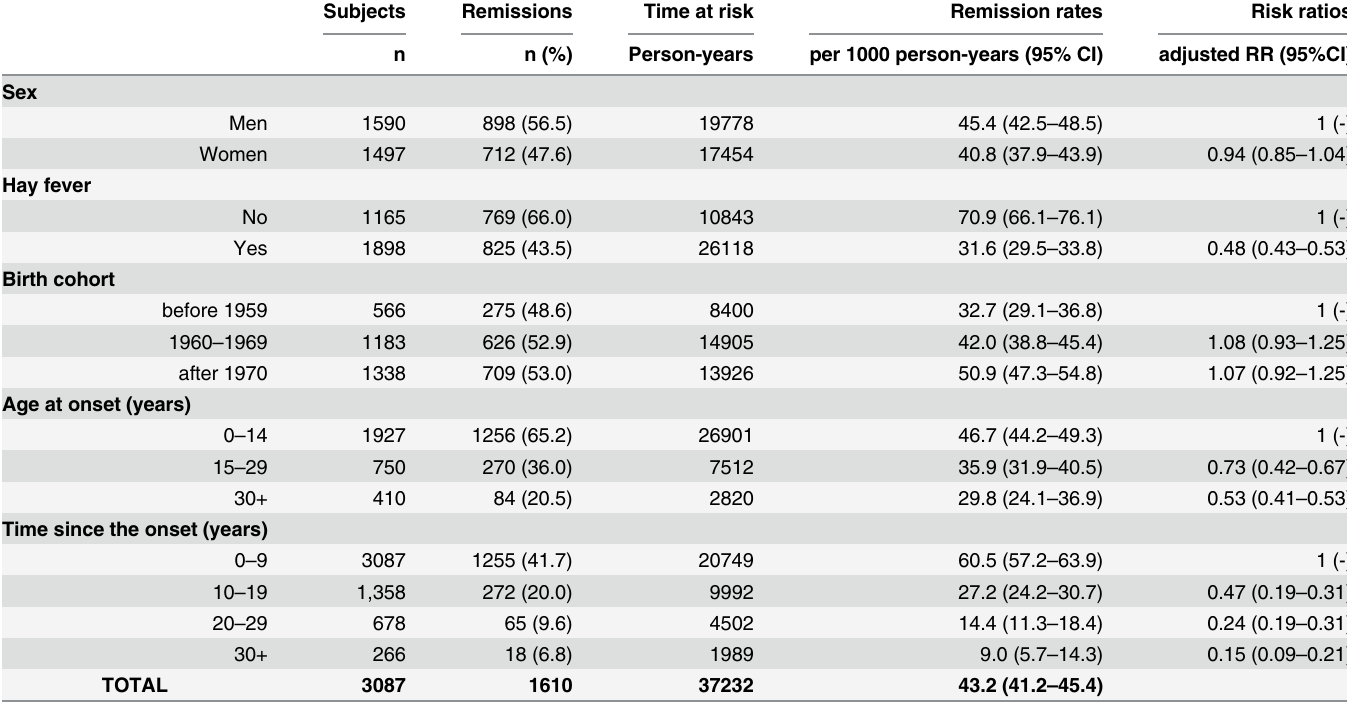
Table 3. Number of subjects with asthma and asthma remissions, crude incidence and risk ratios (RR) of asthma remission adjusted by sex, pres- ence of hay fever, age at onset, birth cohort, and time since